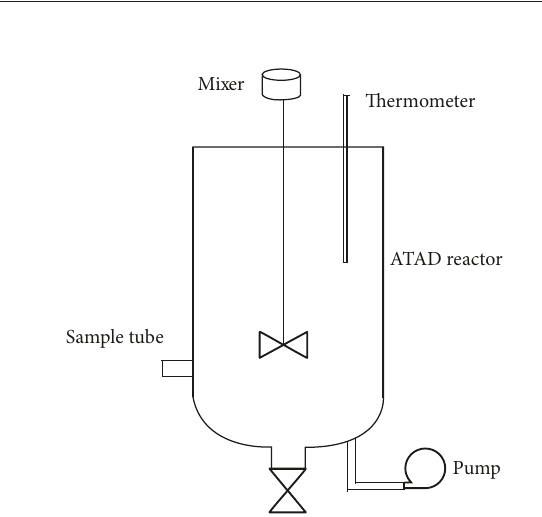
Figure 1: The sketch map of the ATAD experimental